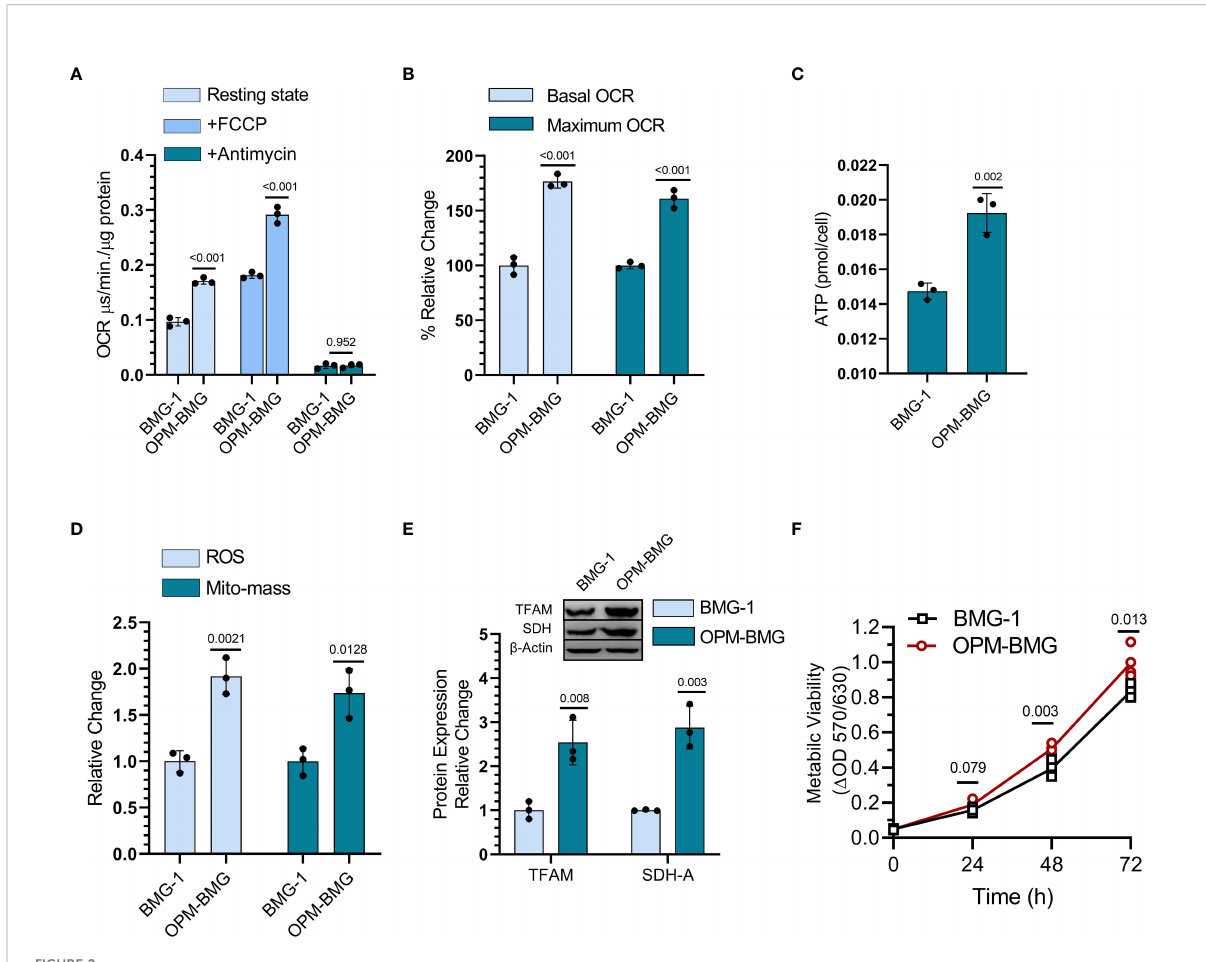
FIGURE 2 DNP modulates mitochondrial respiration. (A) OCR was quanti fi ed as the value of MitoXpressXtra fl uorescence lifetime signal ( m s·/min./ m g protein) with or without FCCP (3 m M) in BMG-1 and OPM-BMG cells (n=3). (B) The overall change in the OCR showed by OPM-BMG cells is presented as % a relative change with respect to BMG-1 (derived information from graph A). (C) ATP content of both BMG-1 and OPM-BMG cells were determined at 24 h post-seeding by ATP bioluminescence assay method, and obtained values were compared among the groups and presented as pmol/cell (n=3). (D) Mitochondrial ROS and mitochondrial mass (Mito-mass) were determined using MitoSox Red and MitoTracker Green, respectively. Column graph showing an increase in mean fl uorescence intensity (MFI) as a relative change for